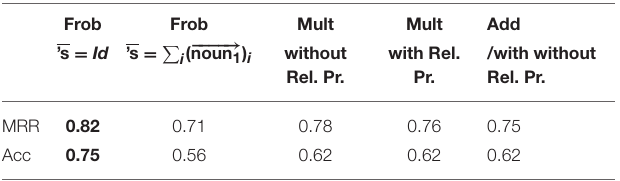
The best performing models are highlighted in boldface.